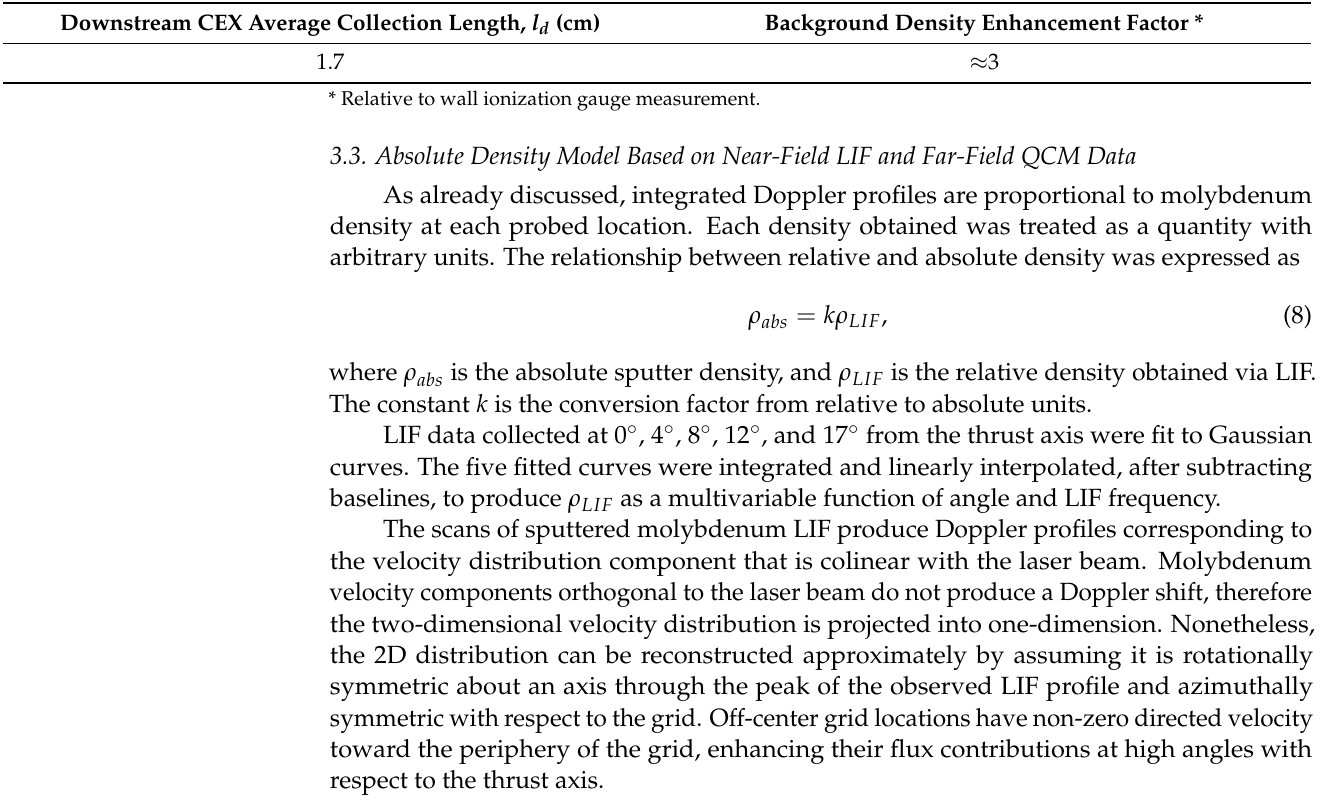
Table 3. Results of accel current collection model for DTL28. The collection length is also a measure of separation distance between ion beam neutralization front and accel downstream